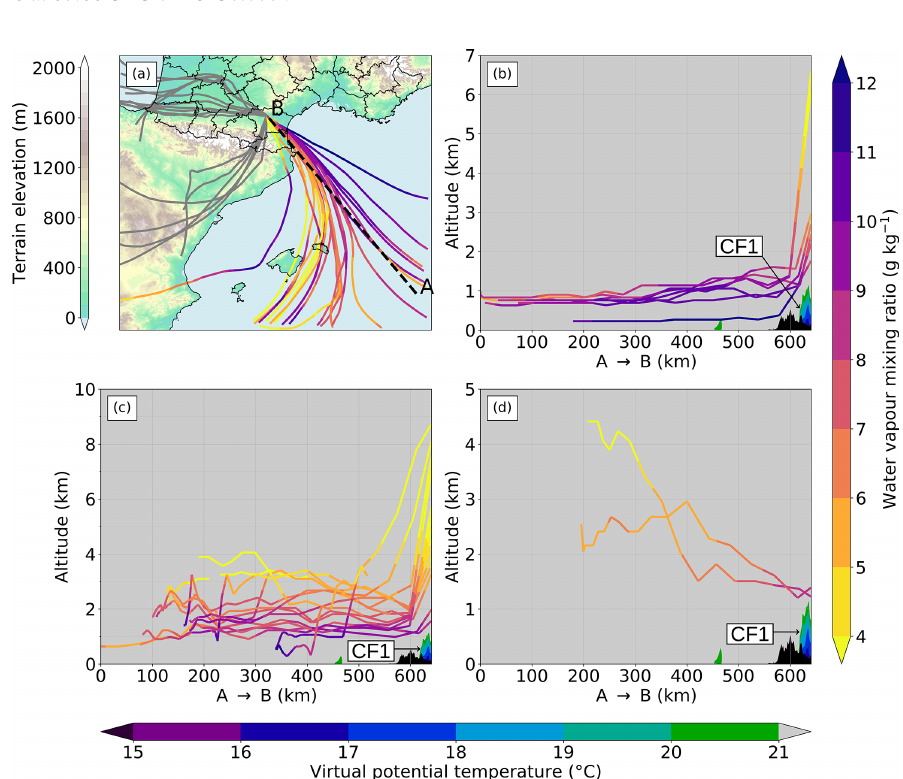
Figure 12. (a–d) As Fig. 9 for trajectories ending at 07:00UTC on 15 October at 43.26 ◦ N, 2.34 ◦ E. Air parcels are projected along the same A–B axis but separated depending on their origin and behaviour: (b) ascending parcels from the east, (c) ascending parcels from the south or west, and (d) descending parcels from the